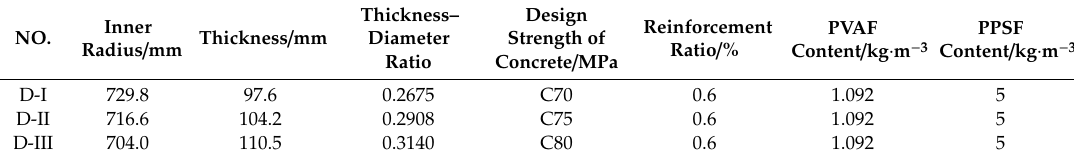
Table 4. Design parameters of the hybrid-fiber-reinforced concrete (HFRC) shaft lining model.